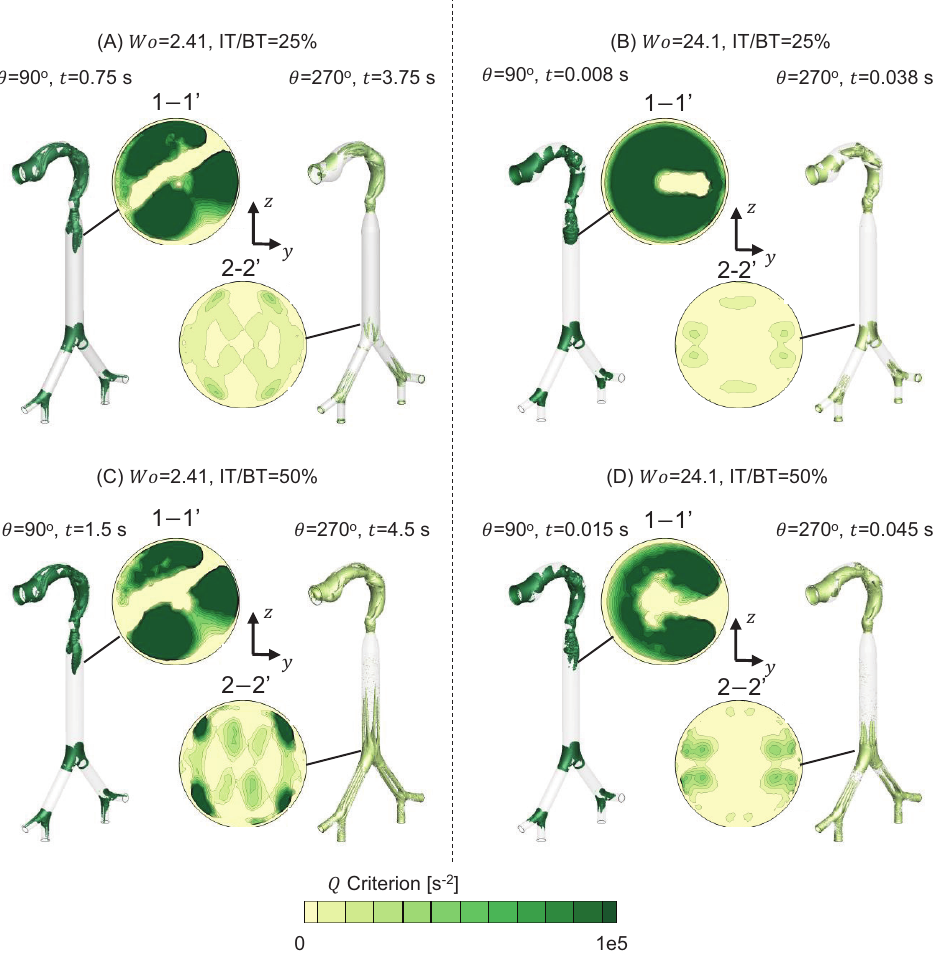
Figure 11. Q -criterion isosurface at peak inhalation ( Q = 100,000 s − 2 ) and peak exhalation ( Q = 15,000 s − 2 ) for all breathing conditions ( A ) Wo = 2.41, IT/BT = 25% ( B ) Wo = 24.1, IT/BT = 25% ( C ) Wo = 2.41, IT/BT = 50%, and ( D ) Wo = 24.1, IT/BT = 50% are shown along with Plane 1 (peak inhalation) and Plane 2 (peak